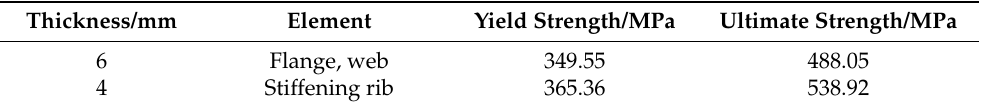
Table 2. Test strength of steel plate.